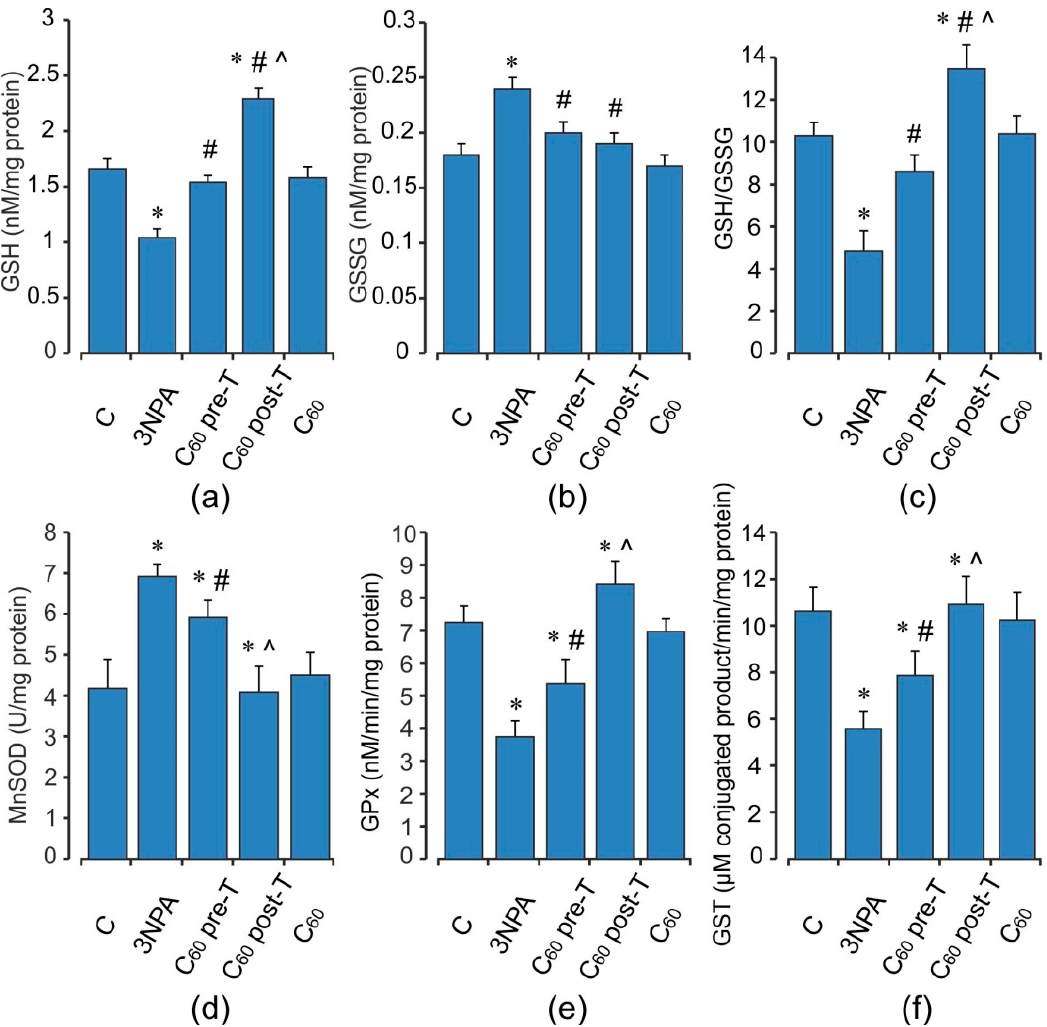
Figure 5. Effect of 3-NPA and C 60 administration on glutathione pool ( a – c ) and MnSOD ( d ), GPx ( e ), and GST ( f ) activities in skeletal muscle mitochondria. Values are means ± SD (replicates = 8). The data were analyzed for statistical significance using ANOVA followed by the Bonferroni post hoc test. (C)—control; (3NPA)—3-nitropropionic acid treated rats; (C 60 pre-T)—C 60 administration in pre-treatment regimen; (C 60 post-T)—C 60 administration in post-treatment regimen; (C 60 )—C 60 administration alone. * p < 0.05 vs. control group; # p < 0.05 vs. 3-NPA treated rats; ^ p < 0.05 vs. C 60 pre-T group.